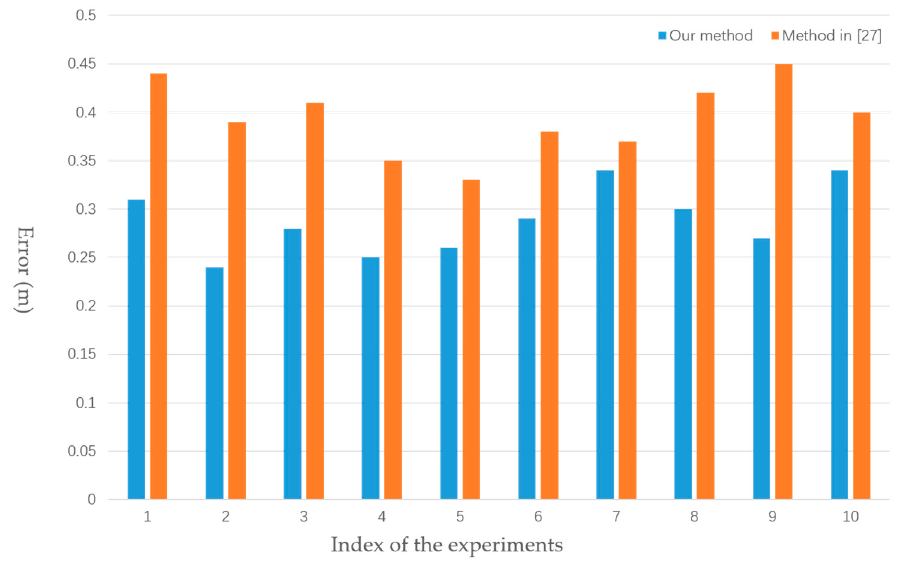
Figure 12. Mean errors of ten experiments with different orientation angles.